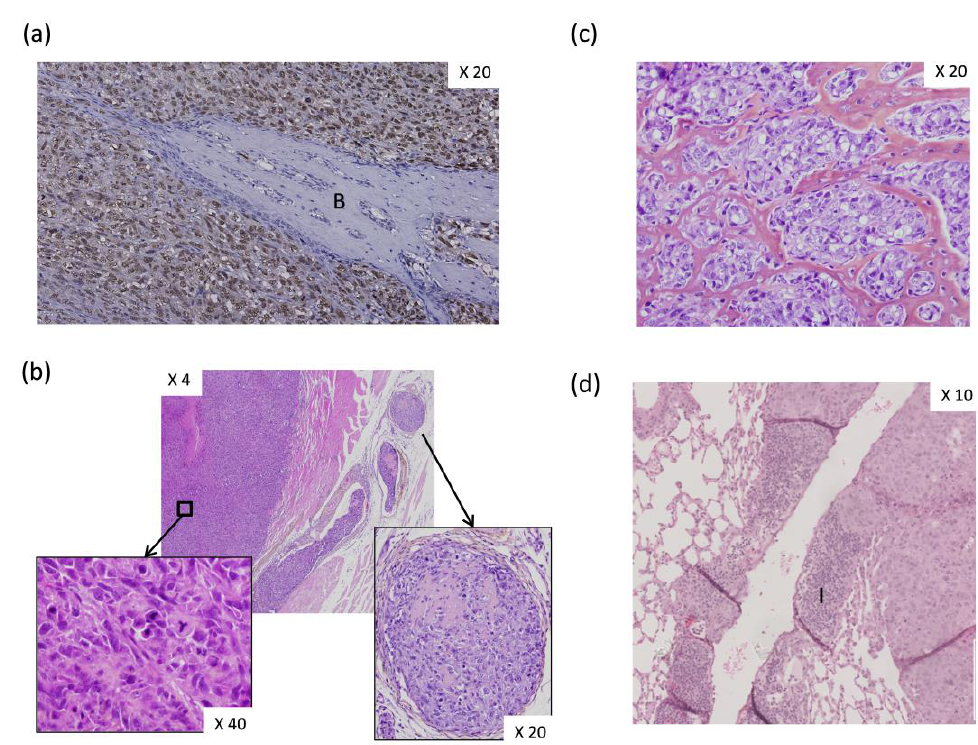
Figure 4. Histological analysis of experimentally induced osteosarcoma (OS) in athymic mice. Human OS-inducing cells (MNNG-HOS cells, CRL-1547, from American Type Culture Collection) were injected either alone ( a , b ) or co-injected with OS-derived stromal cells (OSDCs) ( c , d ) at tibial sites of athymic mice. Tumor samples were fixed in 10% bu ff ered formaldehyde, embedded in para ffi n wax, sectioned, and stained. Magnifications are indicated. ( a ) Human OS cells (brown nuclei) were distinguished from mouse cells (blue nuclei) by in situ hybridization using the human-specific repetitive Alu sequence [65]. Bone (B) spine lined by mouse cells was observed. ( b ) MNNG-HOS-induced tumor section was stained with hematoxylin–eosin–safran solution (HES). Tumor developed in muscle and appeared as an undi ff erentiated pleomorphic sarcoma (magnification in left panel), while osteoid matrix was observed only in intra-vascular tumor emboli (magnification in right panel). ( c ) Following co-injection with OSDC [64], MNNG-HOS-induced tumor was visible with abundant osteoid matrix surrounding anaplastic tumor cells. Tumor section was stained with HES. ( d ) Image of lung metastasis developed from co-injection of MNNG-HOS and OSDCs at paratibial site. Remarkable and non-usual immune cell infiltration (I) was observed in the vessel wall.